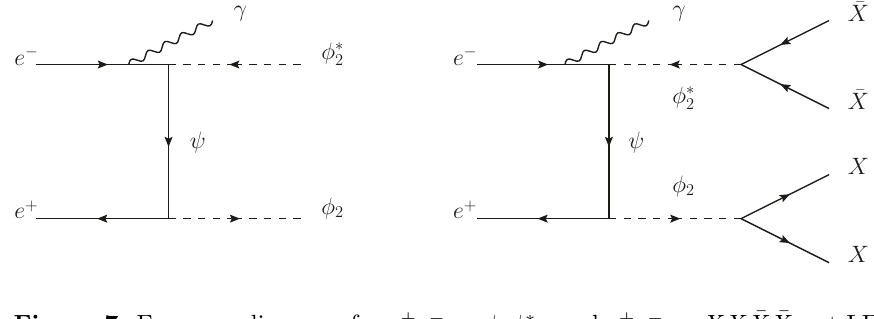
XX (cid:22) X (cid:22) X(cid:13) at LEP. !